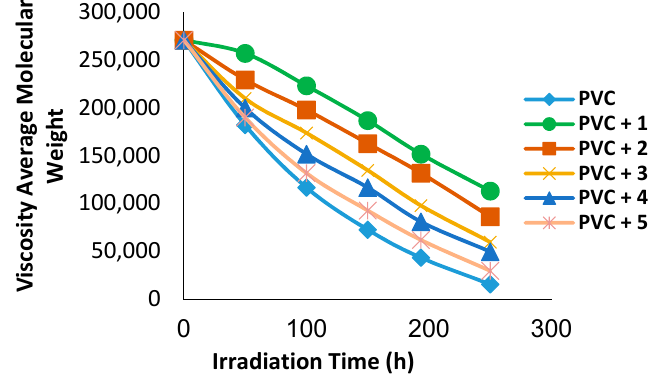
Figure 9. The relationship between the irradiation time (h) and viscosity average molecular weight ((cid:1839)(cid:3365) (cid:2906) ; g/mol) for PVC films (30 μ m thickness) with Schiff’s bases 1 – 5 (0.5% by weight) as additives.